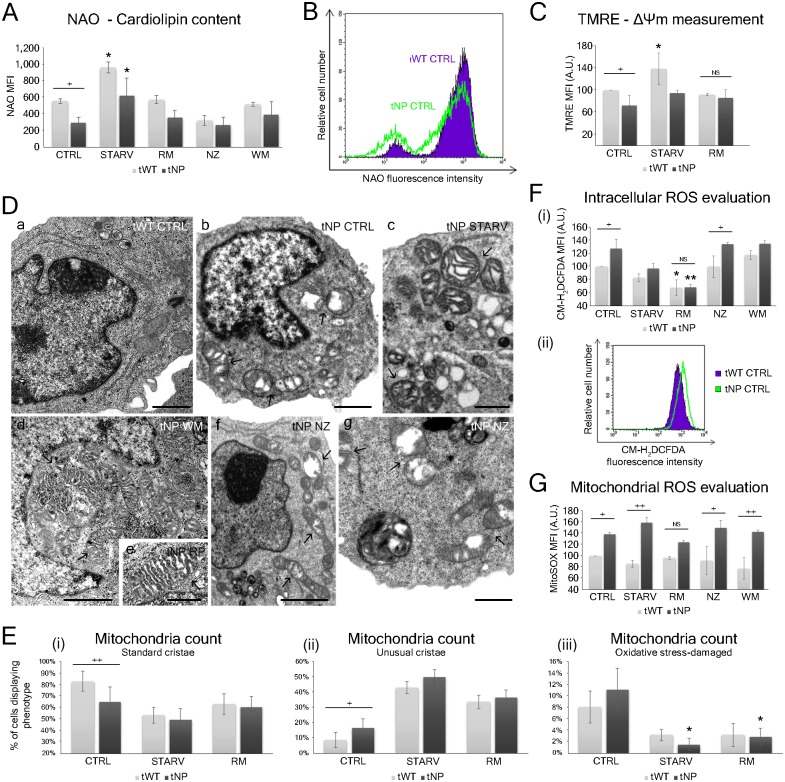
Evaluation of mitochondrial dysfunctional features by flow cytometry and transmission electron microscopy.(A) Statistical histogram of MFI variation of NAO in tWT and tNP cells for each experimental condition. Each value is expressed as a mean ± SD (Results from n ≥ 3 independent experiments); *P < 0.05 vs respective control. The difference between cell lines was significant as shown by two-way ANOVA (***P < 0.001). Two-way ANOVA with Bonferroni post test revealed a P value < 0.05 (+P < 0.05) between tWT and tNP in basal condition. (B) Flow cytometry histogram overlay depicting NAO MFI values of tWT and tNP basal condition. (C) Statistical histogram of MFI variation of TMRE in tWT and tNP cells for control, starved and rapamycin-treated cells. Mean values were converted to arbitrary units (A.U.) setting control values from wild-type cells as 100. Each value is expressed as a relative mean ± SD (Results from n ≥ 3 independent experiments); *P < 0.05 vs tWT control. The difference between cell lines was significant as shown by two-way ANOVA (*P < 0.05). Two-way ANOVA with Bonferroni post test revealed a P value < 0.05 (+P < 0.05) between tWT and tNP in basal condition. (D) Electron microscopy analyses of normal (a) and NP-B B lymphocytes (b-g) in control condition (a, b), and after starvation (c), rapamycin (e), nocodazole (f, g) and wortmannin (d) administration. In Niemann-Pick cells, dysfunctional mitochondria are recognizable (arrows): altered morphology is characterized by dilated and distorted cristae (c, d, e) and by stress-damaged features (b, f, g), absent in non-pathological cells (a). Bars: 1 μm for a, b, c, d, f, g; 0.5 μm for e. (E) Mitochondria from non-pathological and pathological cells were counted and classified according to their morphology—mitochondria with standard cristae (i), mitochondria with unusual cristae (ii) and oxidative stress-damaged mitochondria (iii)–in control, starved and rapamycin-treated cells. Each value is expressed as a percentage ± SD (n = 3; 50 cells counted/experiment); *P < 0.05 vs respective control. Two-way ANOVA with Bonferroni post test revealed a P value < 0.01 and < 0.05 for standard and unusual cristae numbers respectively (++P < 0.01 for standard cristae and +P < 0.05 for unusual cristae) between tWT and tNP in basal condition. (F) ROS detection by CM-H2DCFDA in flow cytometry. (i) Statistical histogram of MFI expression of CM-H2DCFDA in tWT and tNP cells. Mean values were converted to arbitrary units (A.U.) setting control of wild-type cells as 100. Each value is expressed as a mean ± SD (Results from n ≥ 3 independent experiments); *P < 0.05 and **P < 0.01 vs respective control. Two-way ANOVA with Bonferroni post test revealed a P value < 0.05 (+P < 0.05) between tWT and tNP in basal condition and after nocodazole treatment; NS: not significant. (ii) CM-H2DCFDA flow cytometric histograms are overlaid to show the comparison between MFI values of tWT and tNP basal condition. (G) Statistical histogram of MFI expression of MitoSOX in tWT and tNP cells. Mean values were converted to arbitrary units (A.U.) setting as 100 control MFI values of wild-type cells. Each value is expressed as a mean ± SD (Results from n ≥ 3 independent experiments). Two-way ANOVA with Bonferroni post test revealed a P value < 0.05 (+P < 0.05) between tWT and tNP in basal condition and after nocodazole treatment, and a P value < 0.01 (++P < 0.01) between tWT and tNP after starvation and wortmannin treatments; NS: not significant.